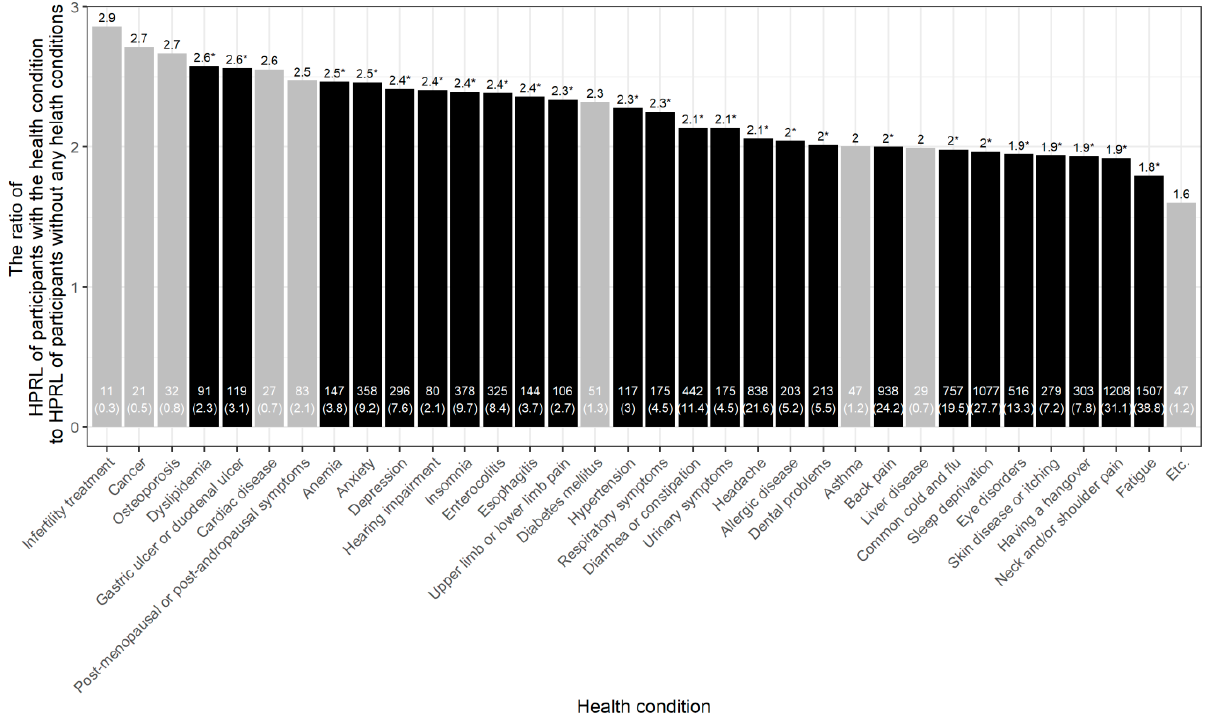
Figure S1 and Supplementary Table S2 summarise the results stratified by gender.